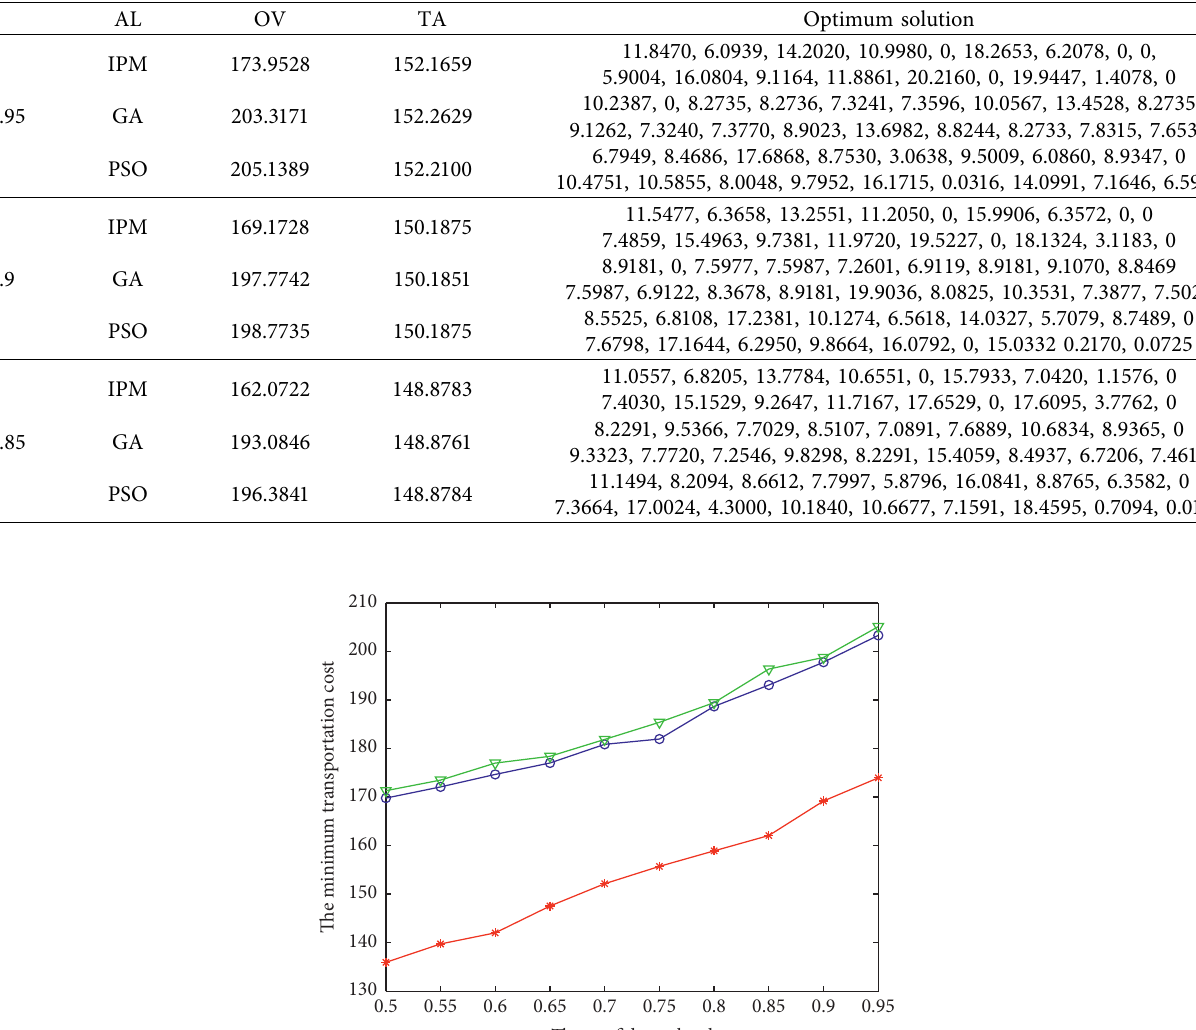
Table 7: Optimal results of the chance-constrained model.